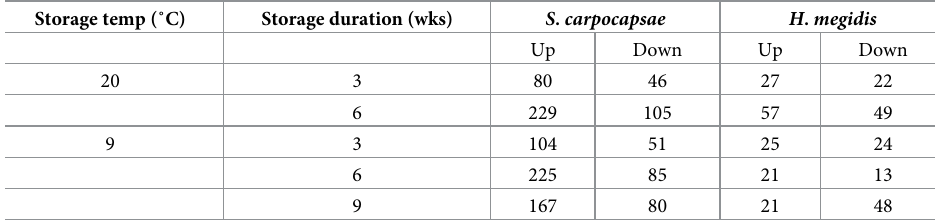
Table 1. Number of significantly significant (P < 0.05) differentially abundant (SSDA) proteins showing increased or decreased activity (fold change +/- 1.5-fold) relative to time 0 following storage at 9˚C or 20˚C of infective juveniles of S . carpocapsae or H . megidis